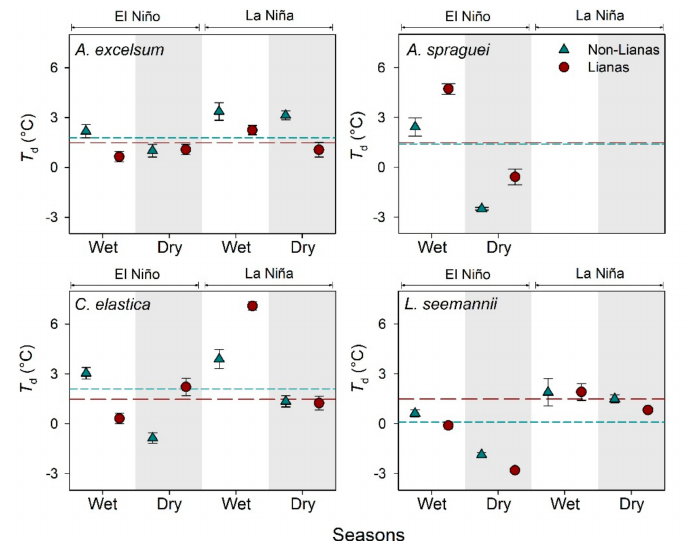
Figure 1. Displayed leaf temperature ( T d ) of tropical tree leaves with and without lianas during the wet and dry season in contrasting ENSO years at the canopy of Parque Natural Metropolitano, Panama. Each point represents the mean ( ± SE). Short dashed lines represent the mean of displayed leaf temperature per tree, while long dashed lines represent the mean of all samples.